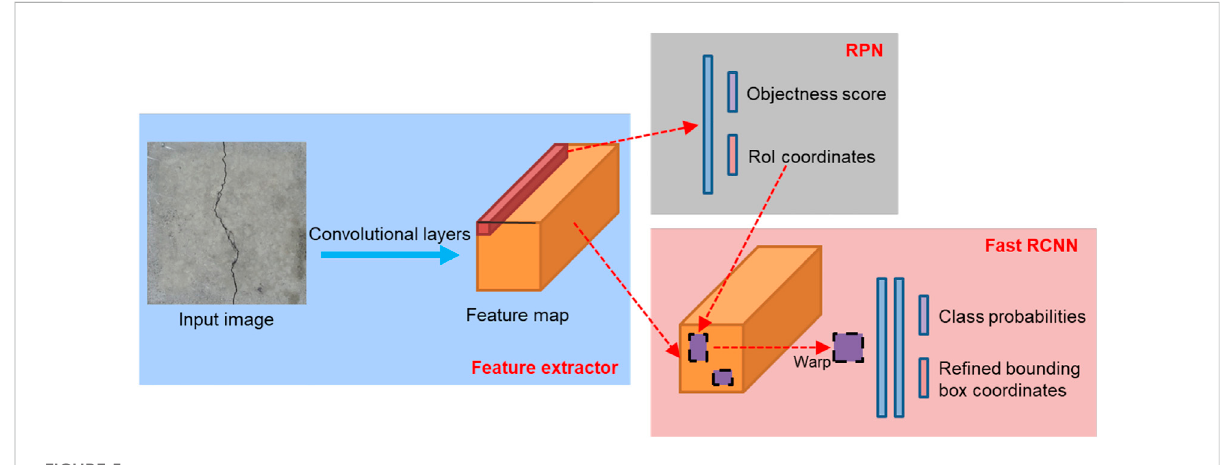
FIGURE 5 Faster RCNN architecture for defect detection.